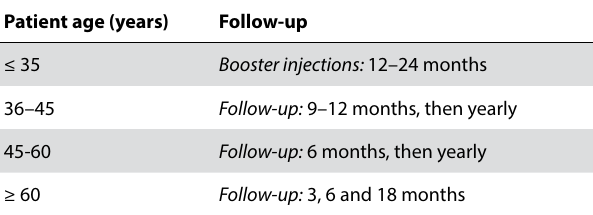
Table 2. 2 Table2: Treatment guidelines for skin rejuvenation